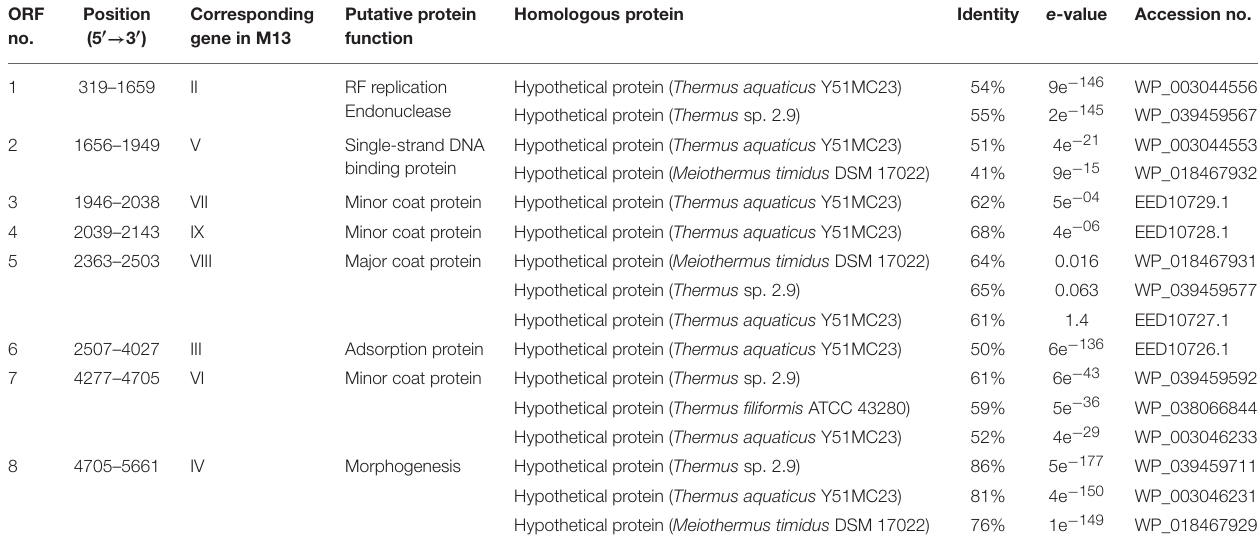
TABLE 1 | Protein-encoding region predicted in the ϕ OH3 genome and their relationship to amino acid sequences from the databases. ORF